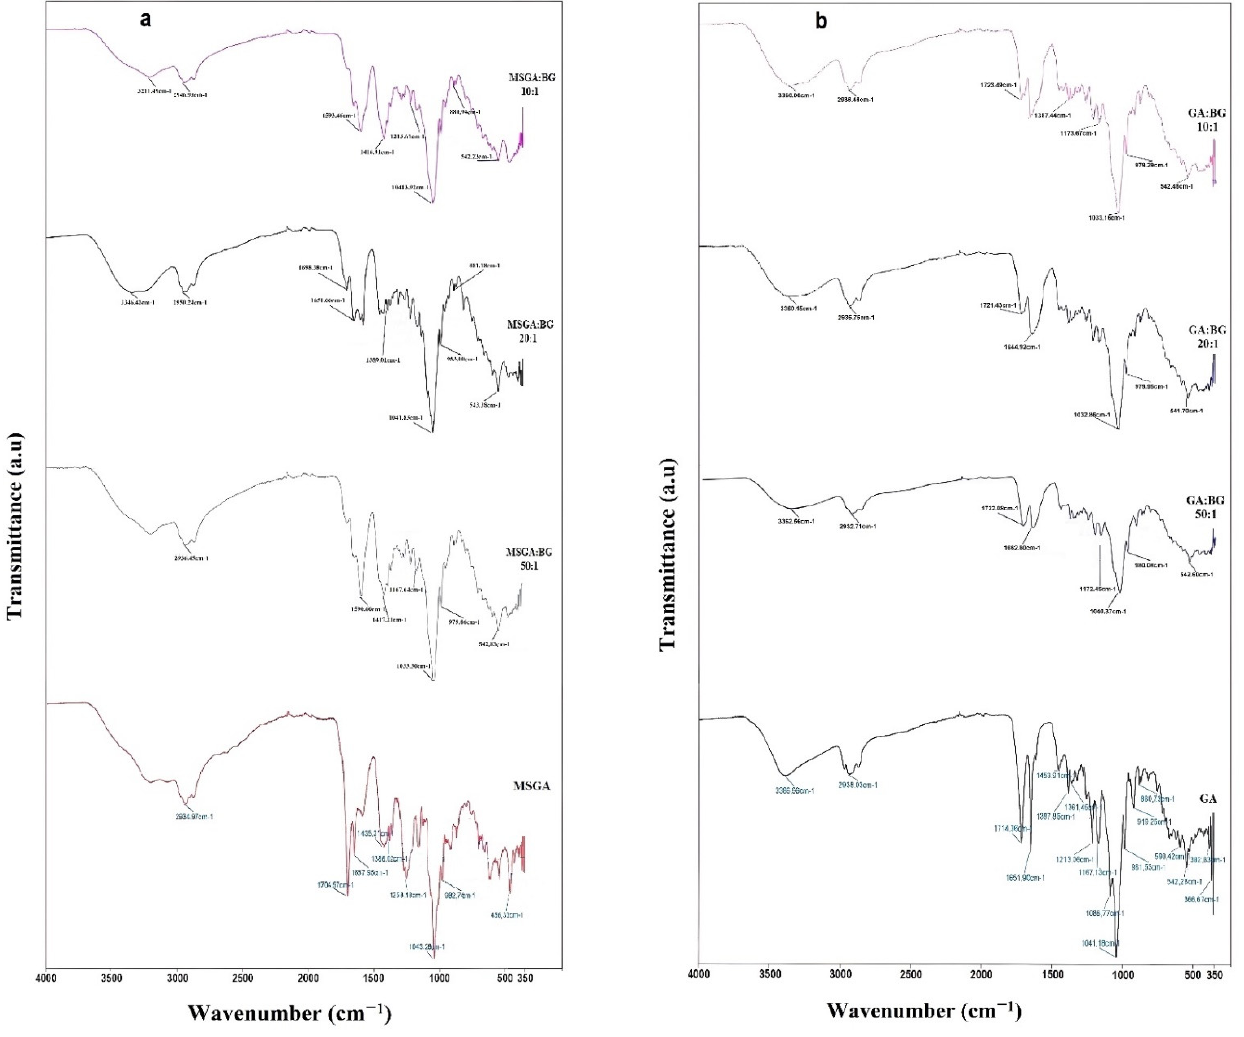
Figure 3. FTIR spectra of ( a ) MSGA and MSGA:BG complexes, ( b ) GA and GA:BG complexes. UV spectra of the supramolecular complexes of MSGA:BG (Figure 4a) and GA:BG